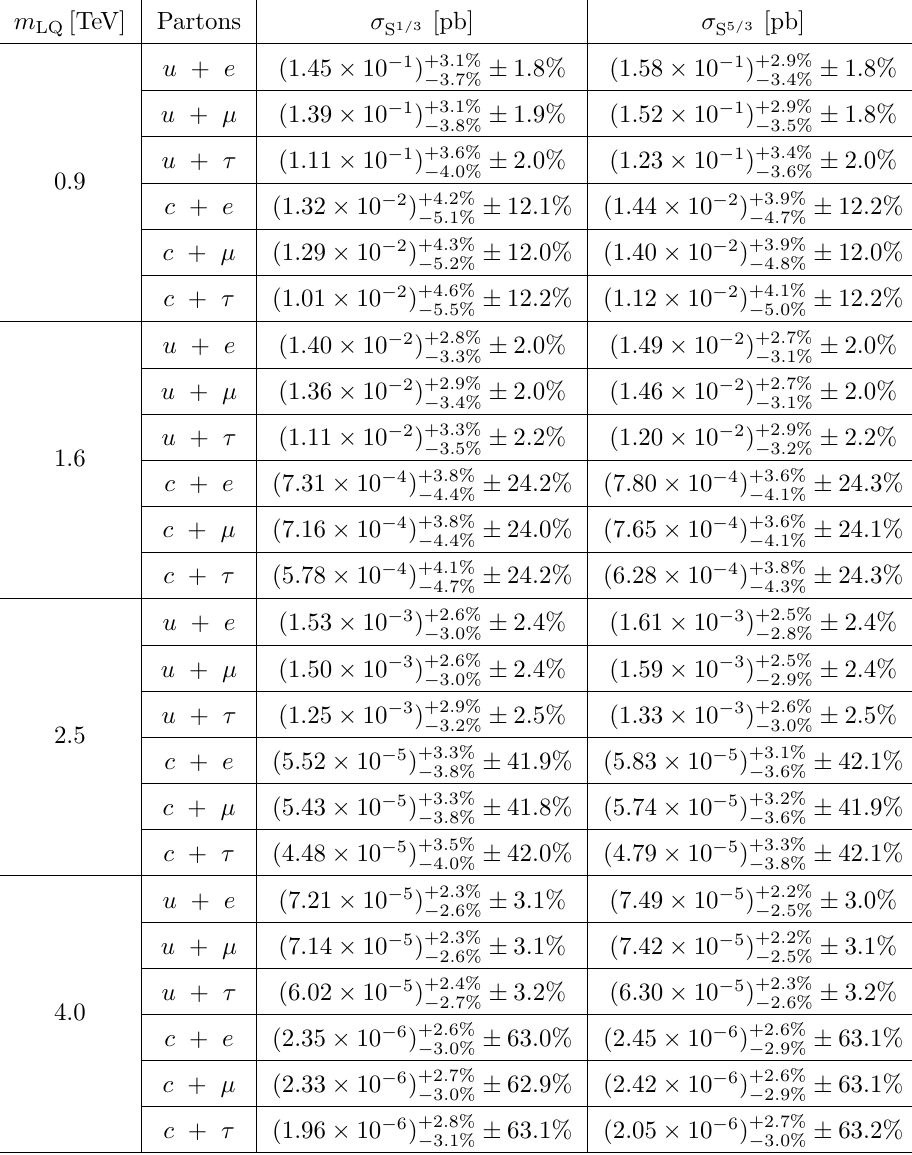
Table 1 . Inclusive cross sections in pb for the resonant leptoquark production from up-type quarks, pp → LQ + charge-conjugated process, as a function of the leptoquark mass m LQ at The cross section σ ( σ ) corresponds to the resonant production of scalar LQ with absolute S 1 / 3 S 5 / 3 electric charge 1 / 3 (5 / 3) when the associated Yukawa coupling strength is set to one, y q‘ = 1 . The second column denotes which quark-lepton pair couples to the corresponding leptoquark. First (second) uncertainty is due to the renormalisation and factorisation scale variations (PDF replicas), and is given in per cent units. See section 3 for